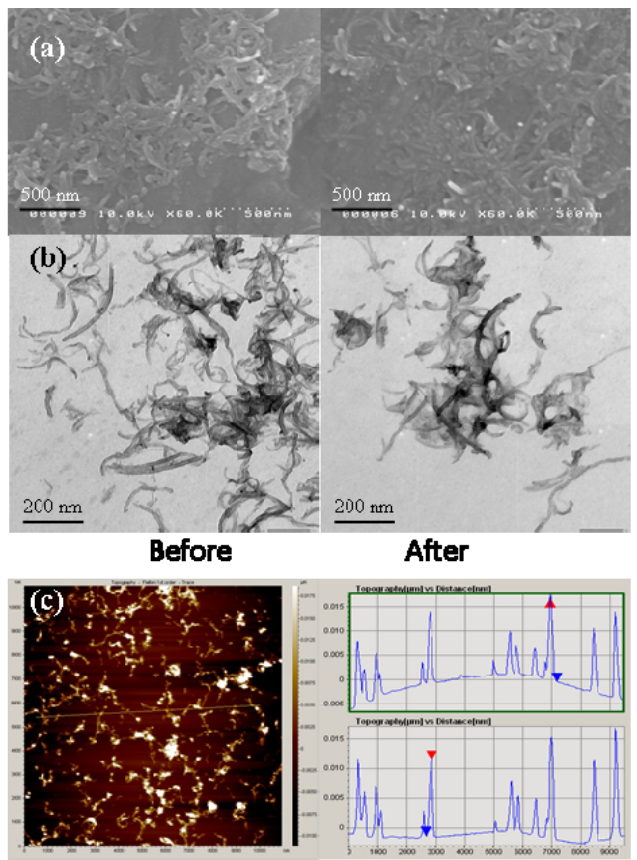
Figure 1. ( a ) SEM (Bar: 500 nm); ( b ) TEM (Bar: 200 nm) micrographs of MWNTs before and after suspended in a modified Hoagland medium; and ( c ) AFM image of MWNTs before suspended in a modified Hoagland medium, depicts the morphology of MWNTs. Reproduced with permission from reference [17], Copyright 2012, Elsevier.